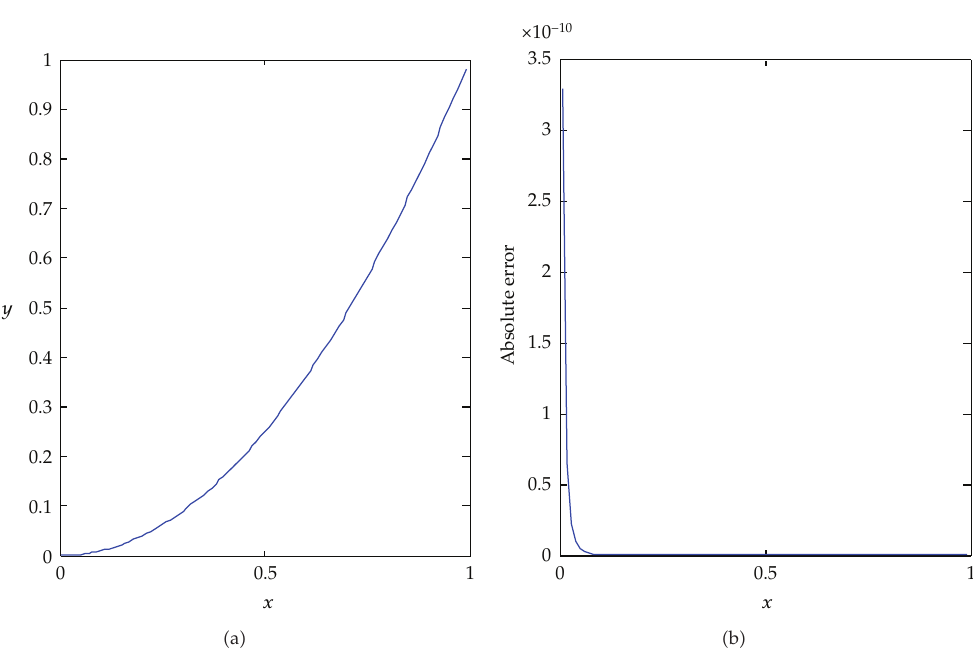
Figure 5: Numerical solution and absolute error of Example